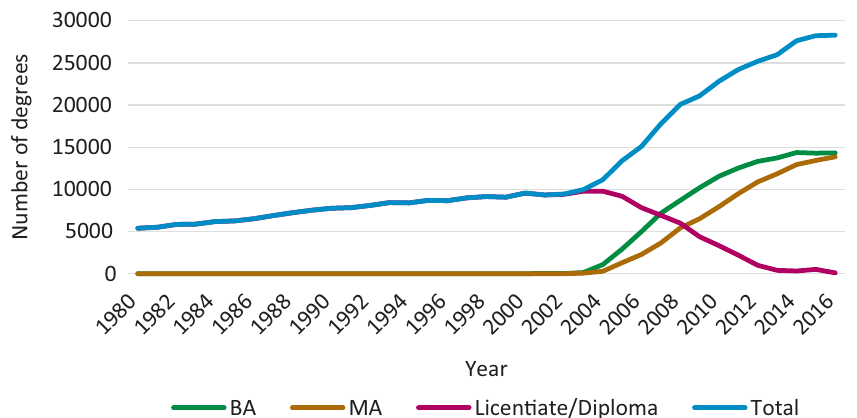
Figure A1. Development of degrees in Switzerland from 1980 to 2016 (absolute figures, men and women). Data: FSO (2017); own